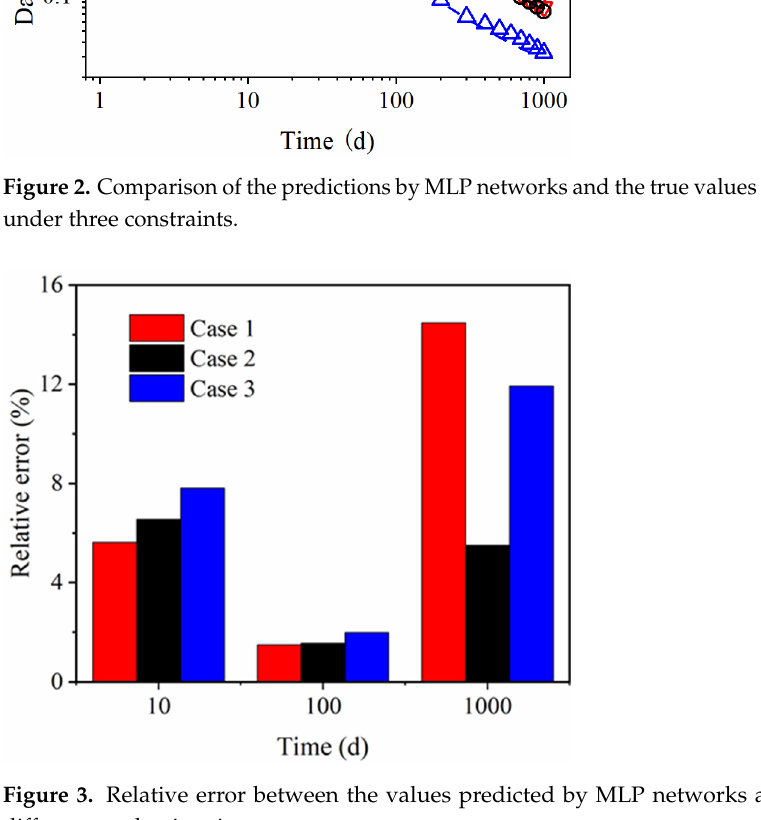
Figure 2. Comparison of the predictions by MLP networks and the true values of the daily produc- tion under three constraints.